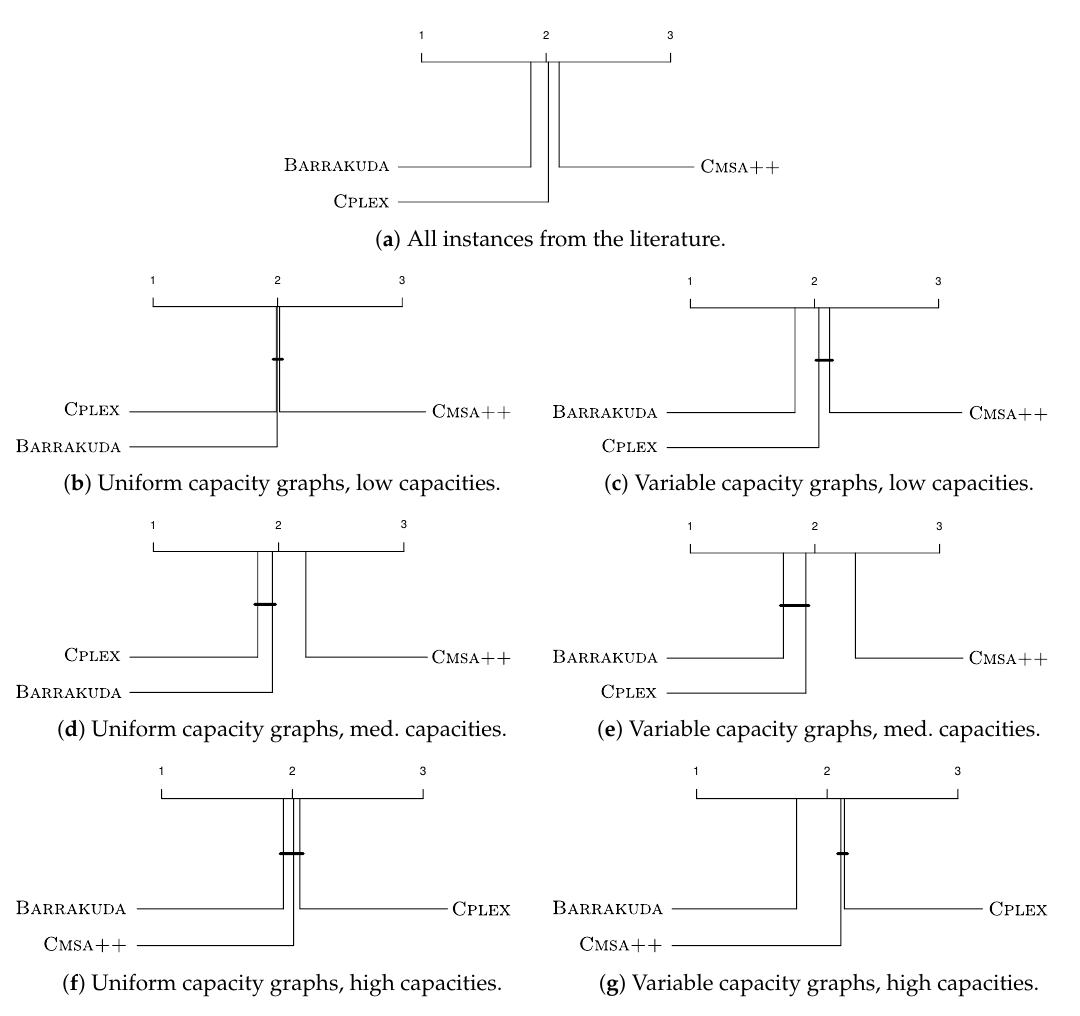
Figure 4. Critical difference plots concerning the problem instances from the literature.